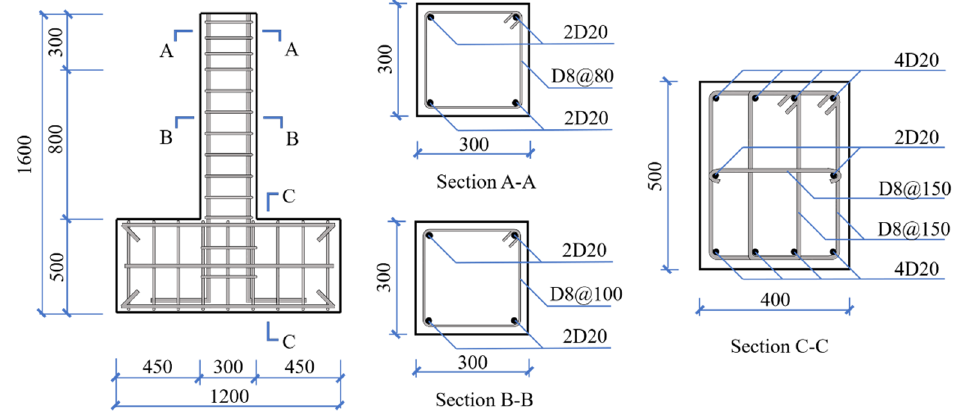
Figure 2. Specimen details (unit: mm). Note: section A-A, section B-B and section C-C in the figure are the reinforcement details of the corresponding positions of the specimen respectively.